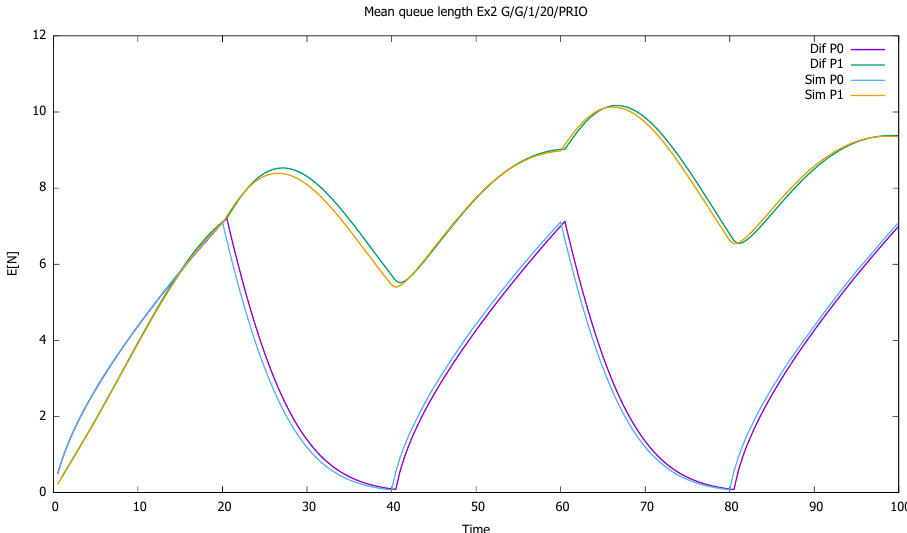
Figure 5. Section 3.2, medium load: mean queue lengths of priority (P0) and non-priority (P1)